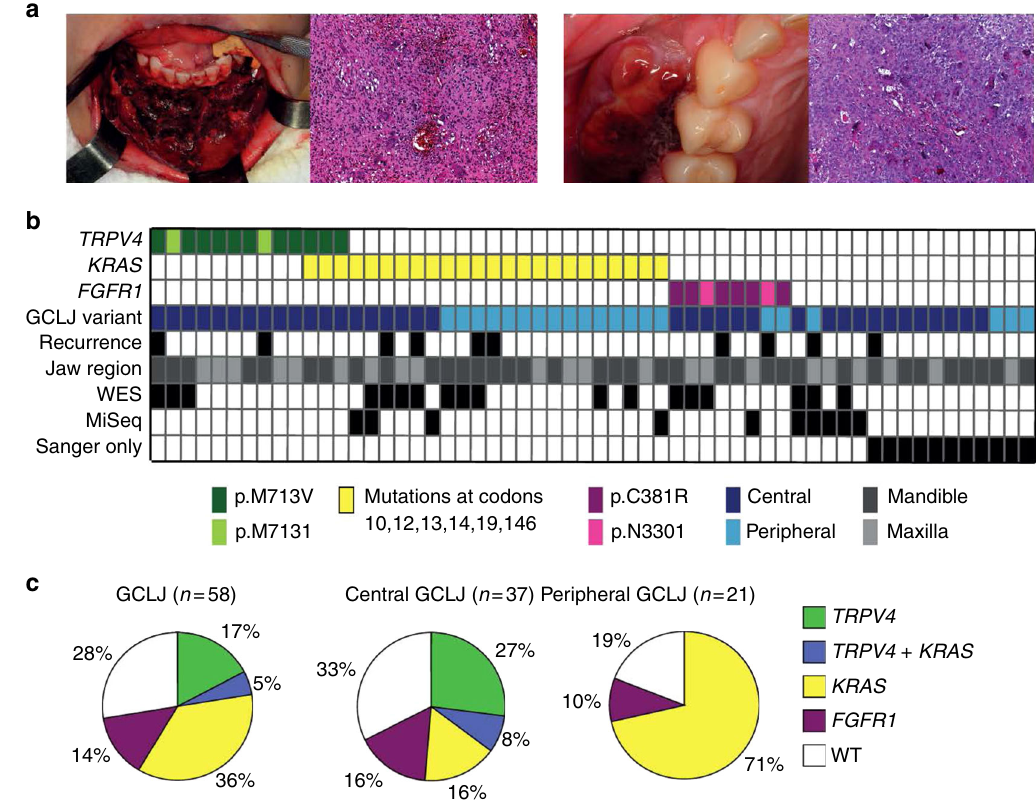
Fig. 1 TRPV4 , KRAS and FGFR1 mutations drive central and peripheral giant cell lesions of the jaw (GCLJ). a Clinical image of an aggressive central GCLJ showing a large destructive bone lesion occurring in anterior mandible (left). Histologically, the lesion is composed of multinucleated osteoclast-like giant cells intermingled with oval to spindle-shaped mononuclear cells in a hemorrhagic stroma. Clinical image of a peripheral exophytic GCLJ (right). Histologically, the lesion is similar to that the central form. b Summary of TRPV4 , KRAS , and FGFR1 mutations identi fi ed in GCLJ. c Spectrum of TRPV4 , KRAS , and FGFR1 mutations in all GCLJ (left), central GCLJ, showing TRPV4 mutations are exclusive to this form (middle), and peripheral GCLJ